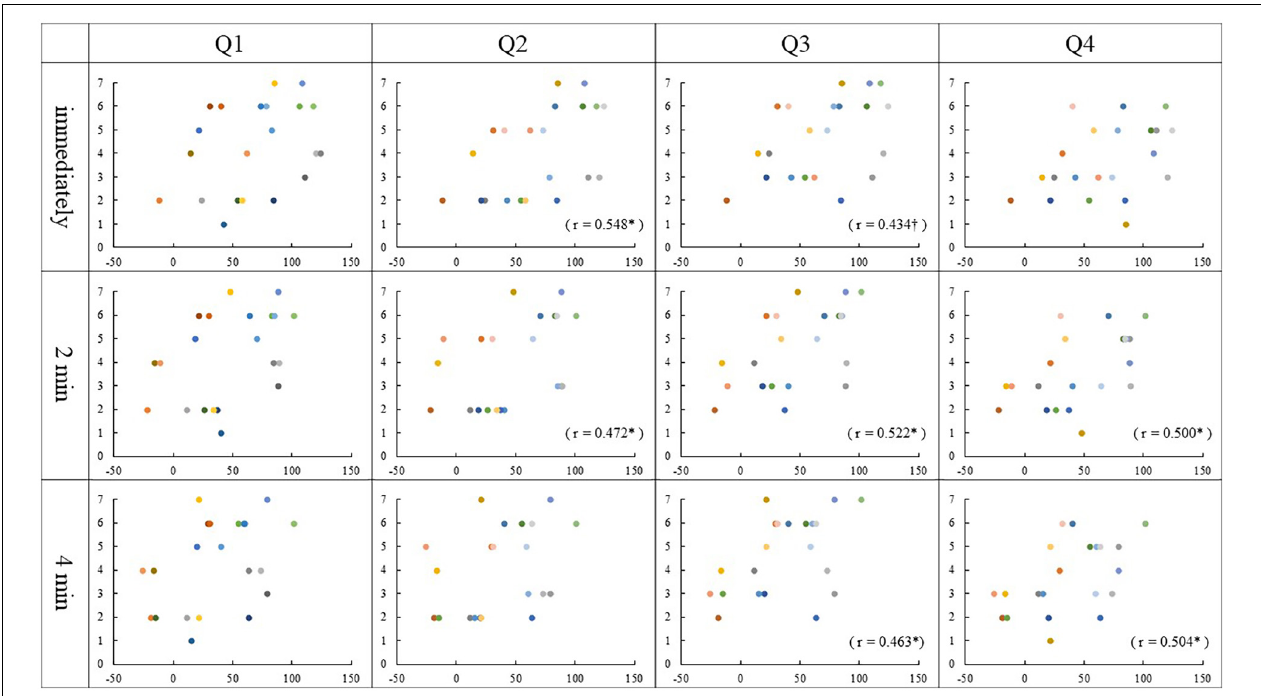
FIGURE 5 | Relationship between PD values and Questionnaire in the asynchronous condition: The vertical and horizontal lines indicate the rating scale and the PD value, respectively. The PD values were calculated by subtracting each position after stimulation from the baseline (mm). ∗ p < 0.05; † p = 0.05.